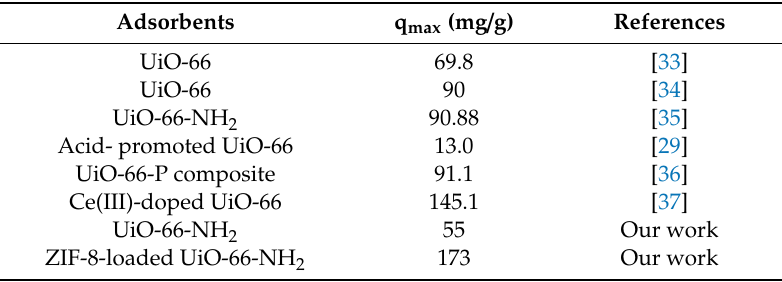
Table 3. Comparison of methylene blue (MB) maximum adsorption capacities on various metal organic frameworks (MOFs).